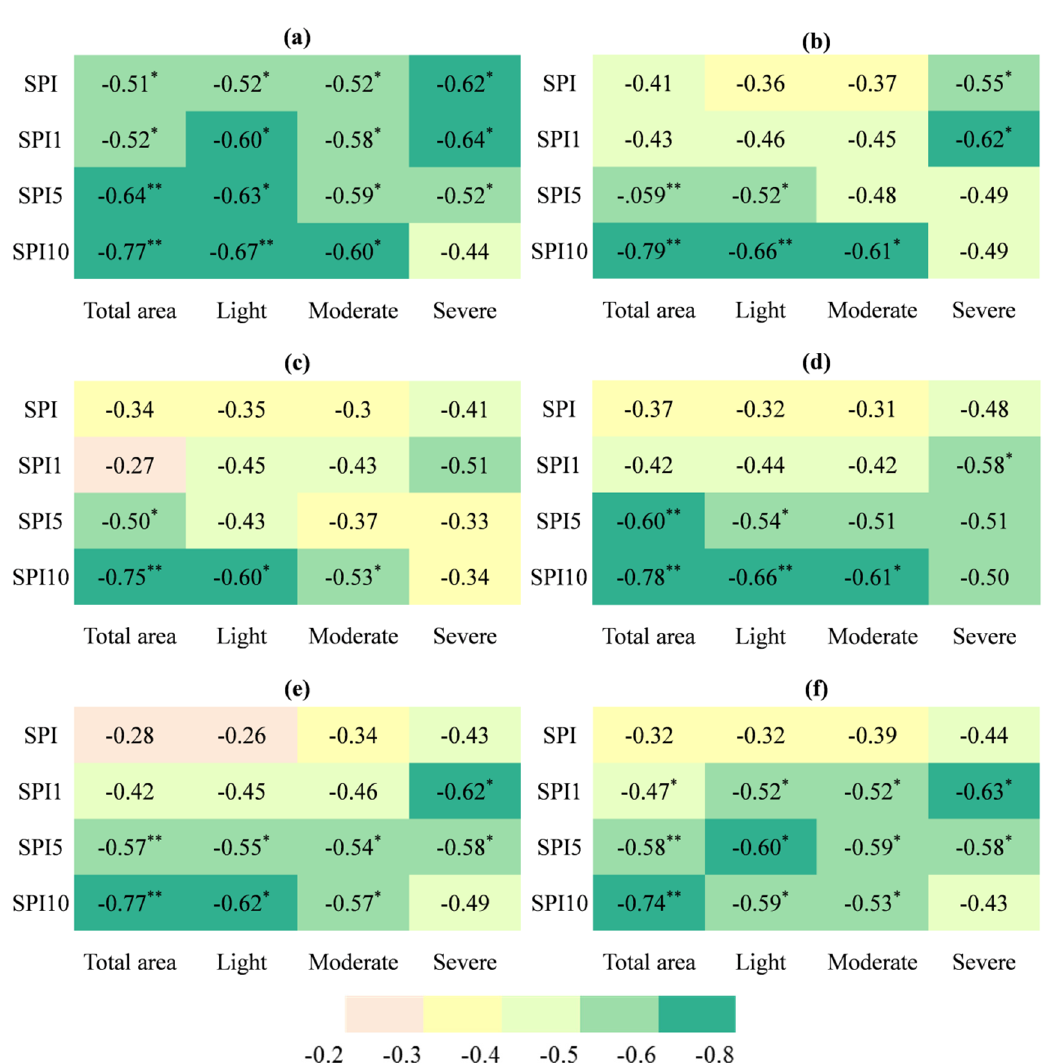
Figure 5. Effect of Standard Precipitation Index on pine caterpillar outbreak. Values are Pearson’s correlation coefficients for the correlation of pine caterpillar outbreak and SPI, SPI10, SPI5, and SPI1 at year ( a ), growing season ( b ), spring ( c ), summer ( d ), autumn ( e ), and winter ( f ) scale for 1992–2012. ** and * indicate p < 0.01 and p < 0.05, respectively.